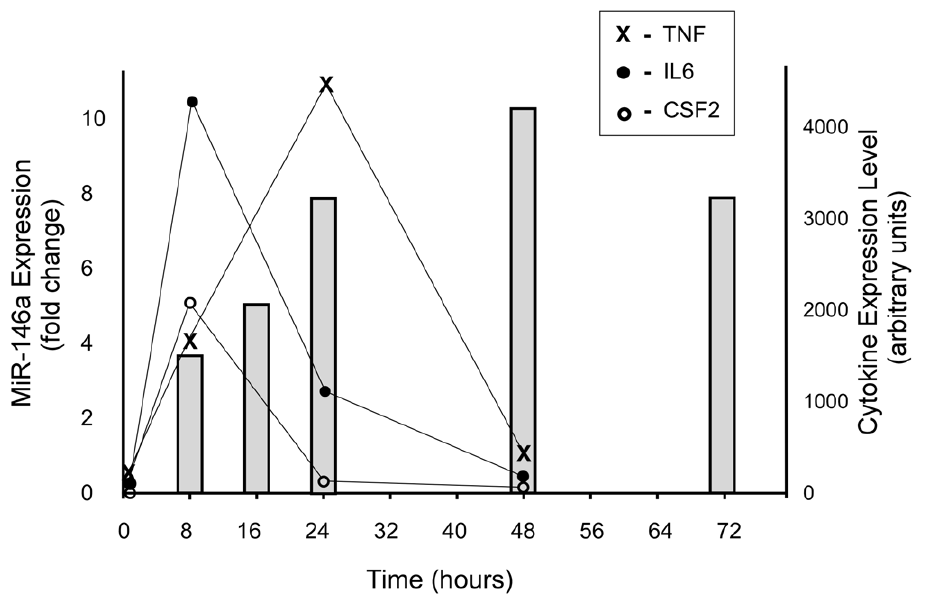
Figure 3. EOC 13.31 cells were stimulated with 100 ng/ml semi-pure LPS and temporal changes in cytokine gene expression relative to mock-treated control were measured by microarray analysis. MiR-146a expression relative to mock-treated control was measured by TaqMan H qRT-PCR and expression is shown as grey bars.